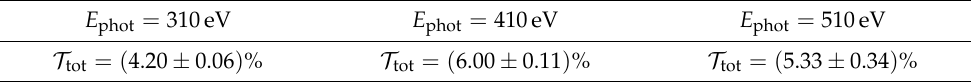
Table 3. Overall transmission, based on diffraction efficiencies of RZP 1,2 and reflectivity of the PM. E phot = 310eV E phot = 410eV E phot = 510eV T tot = ( 4.20 ± 0.06 ) % T tot = ( 6.00 ± 0.11 )